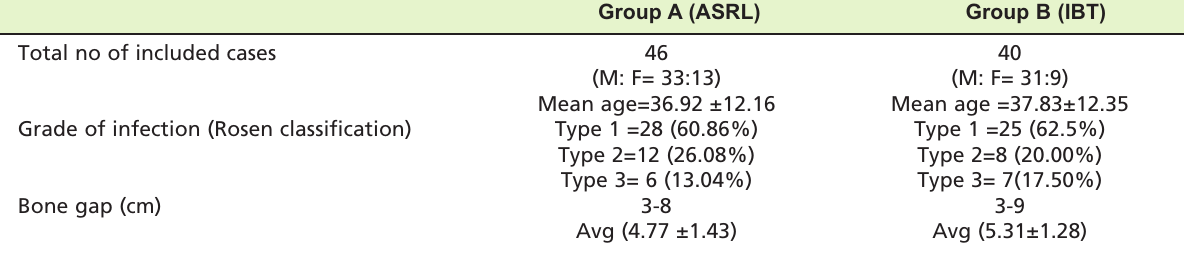
Pre-op patient Table II: